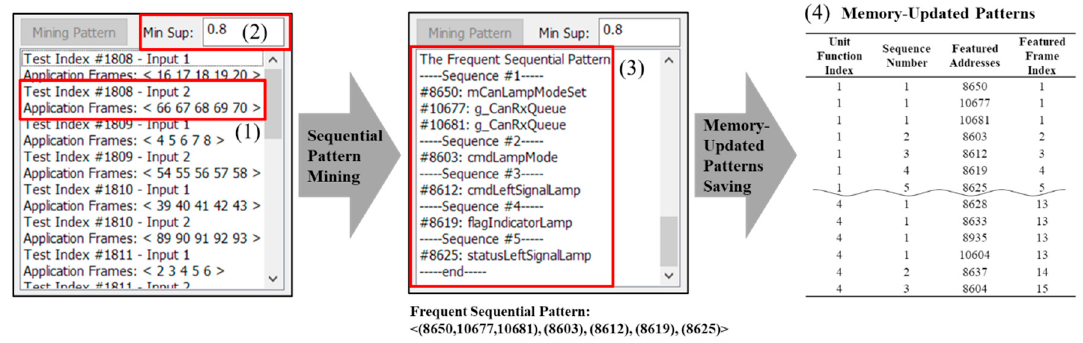
Figure 5. Example of sequential pattern mining of memory-updated information.